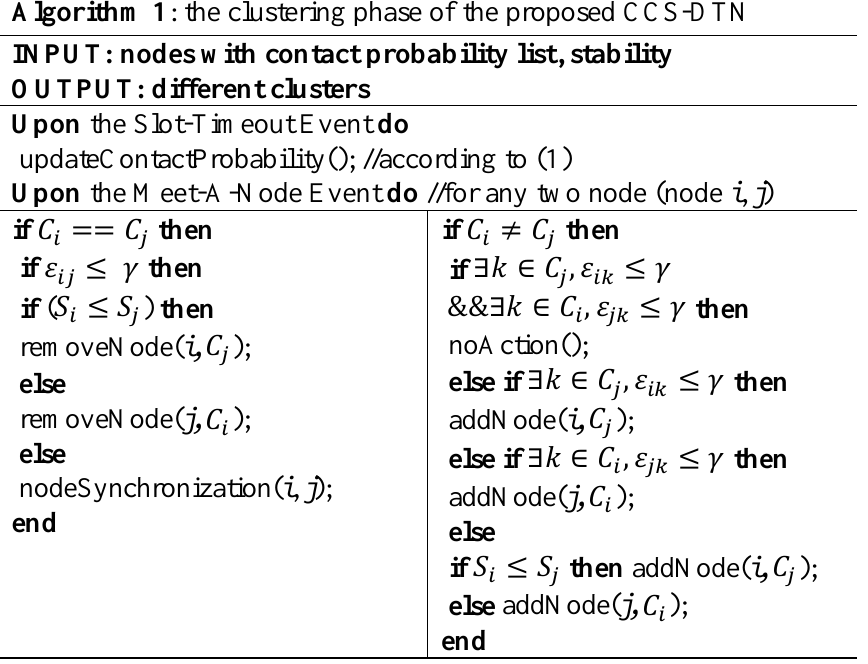
Algorithm 1 : the clustering phase of the proposed